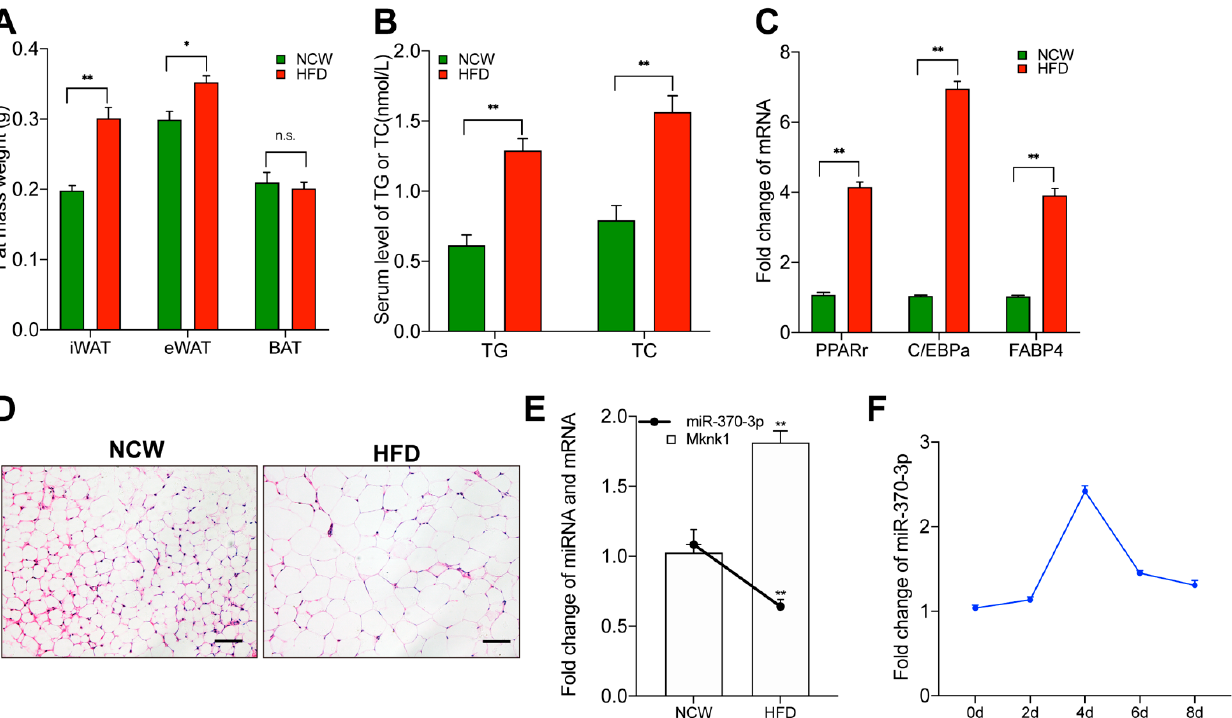
Figure 1. miR-370-3p is associated with adipogenesis. ( A ) The weight of iWAT, eWAT, BAT fat mass from HFD and NCW fed mice. ( B ) Triglycerides (TG) and total cholesterol (TC) were measured. ( C ) The mRNAs expression level of PPAR γ , C/EBPa, FABP4 was measured in adipose tissues. ( D ) H&E staining for epididymal white adipose tissue (eWAT) from mice fed with HFD and NCW. ( E ) The expression of miR-370-3p and Mknk1 in eWAT from HFD- and NCW-fed mice. ( F ) The mRNAs expression level of miR-370-3p was quantified during the differentiation process. Scale bars were 50 μ m. All results are presented as means ± SEM. n = 3 per treatment. Each treatment represents the mean of three replicates. * p < 0.05; ** p < 0.01, n.s. no significant difference.